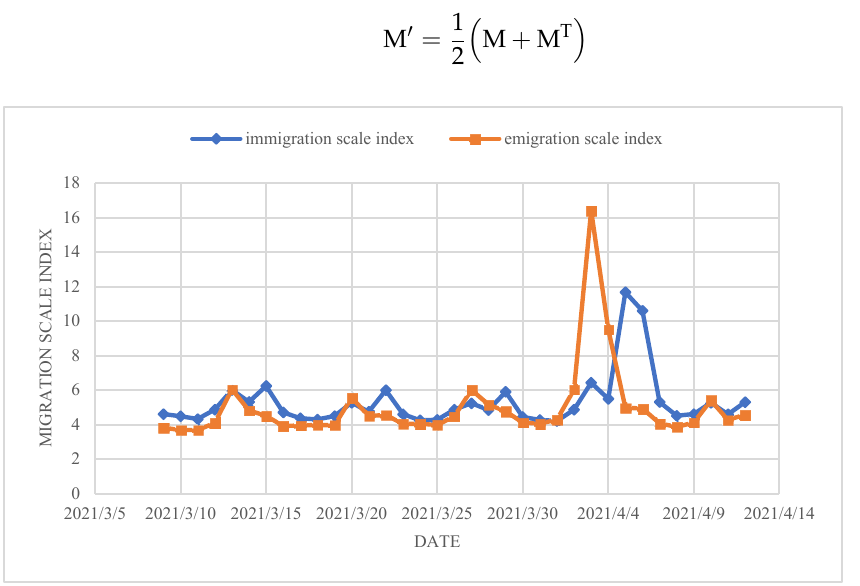
Figure 3. Line chart of migration scale index (taking Zhengzhou as an example).